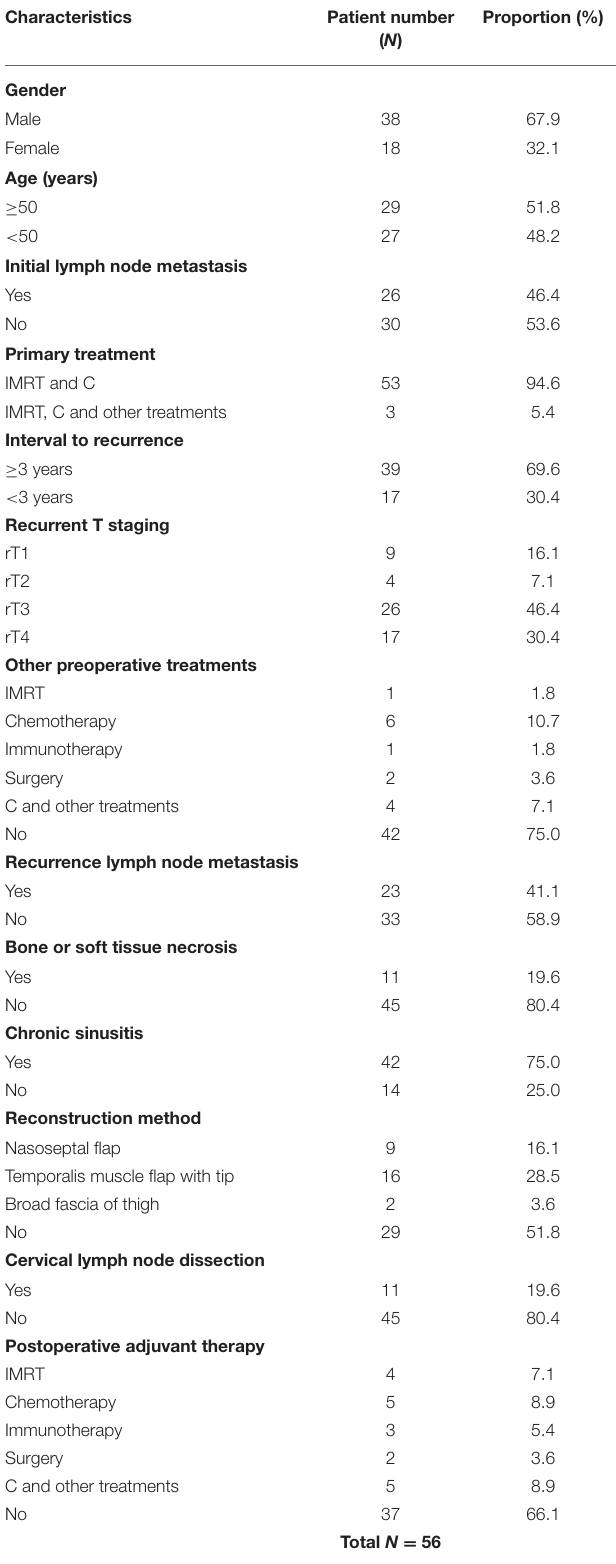
TABLE 1 | Demographics and clinical characteristics of recurrent nasopharyngeal carcinoma.